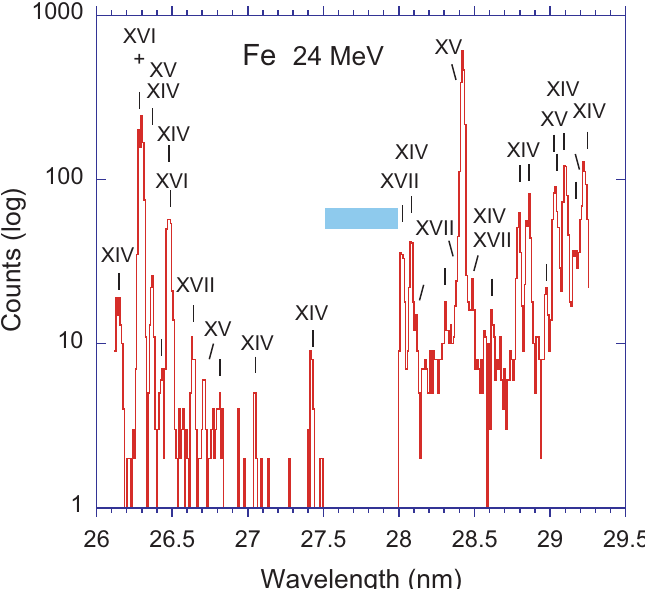
Figure 13. Beam–foil spectra of Fe at an ion beam energy of 24 MeV. Line width (FWHM) 0.03 nm. The strongest lines are identified by the spectrum number. Unidentified lines are marked by a fiducial. The charge state distribution is centered on q = 13 + , and ion charge states q = 9 + to q = 17 + are expected to contribute in principle. Two separate measurements have been combined in one plot. The blue horizontal bar from 27.5 nm to 28 nm marks the gap in